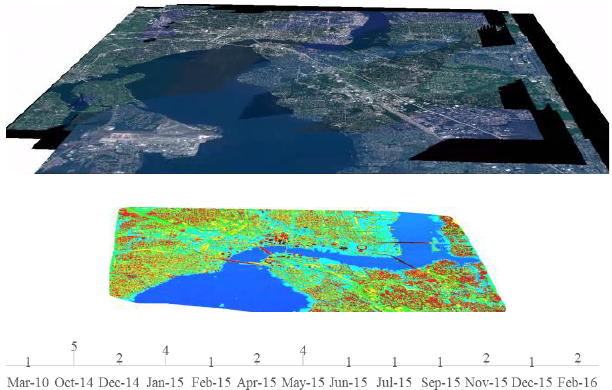
Figure 3. Overview of the 1 WorldView-2 and 26 WorldView-3 images in two years (above), and the acquired LiDAR-DSM (middle). The imaging time is summarized (bottom).